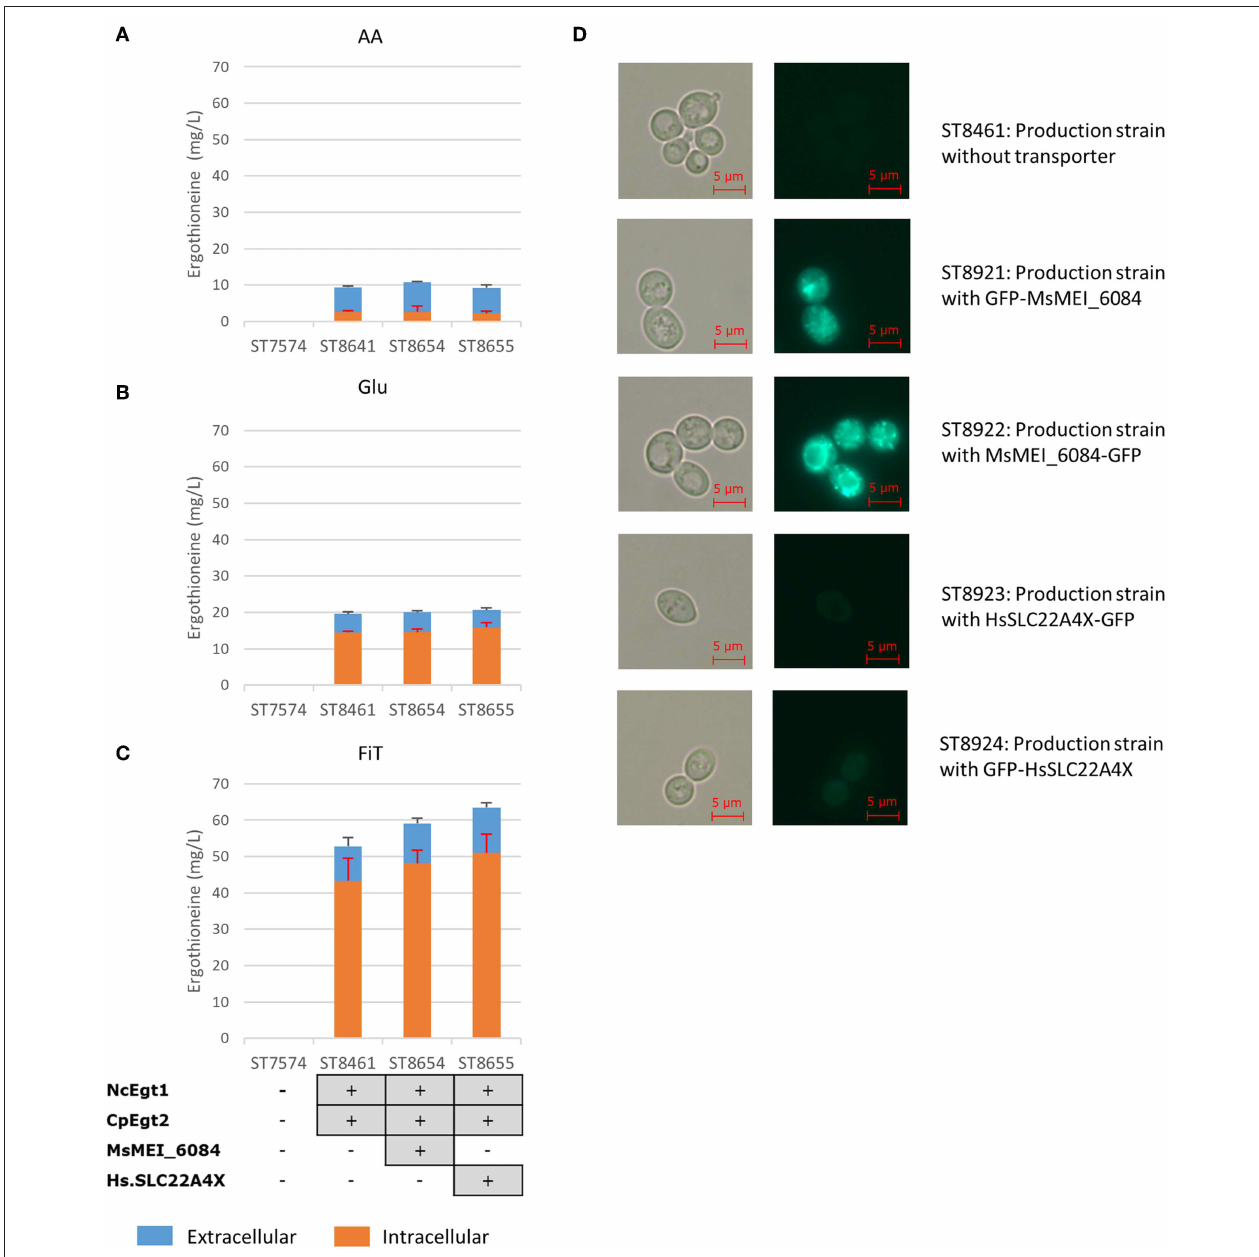
FIGURE 3 | Ergothioneine production by yeast strains expressing human ERG transporter SLC22A4X or a putative ERG transporter from M. smegmatis on three variations of synthetic complete medium: (A) AA: 20 g/l glucose and 1 g/l of each L-His, L-Met, and L-Cys, (B) Glu: 40 g/l glucose, (C) FiT: 60 g/l EnPump substrate for slow glucose release to simulate fed-batch conditions, (D) Microscope images of yeast cells with ergothioneine transporters linked to GFP. To the left are Brightfield images and to the right GFP images. Top panels; ST8461, ergothioneine producing strain without transporter. Middle-top panels, ST8921, ergothioneine producing strain with a putative transporter from Mycobacterium smegmatis linked to GFP at the N-terminus. Middle panels, ST8922, ergothioneine producing strain with a putative transporter from Mycobacterium smegmatis linked to GFP at the C-terminus. Middle-bottom panels, ST8923, ergothioneine producing strain with a transporter from Homo sapiens linked to GFP at the C-terminus. Bottom panels, ST8924, ergothioneine producing strain with a transporter from Homo sapiens linked to GFP at the N-terminus.